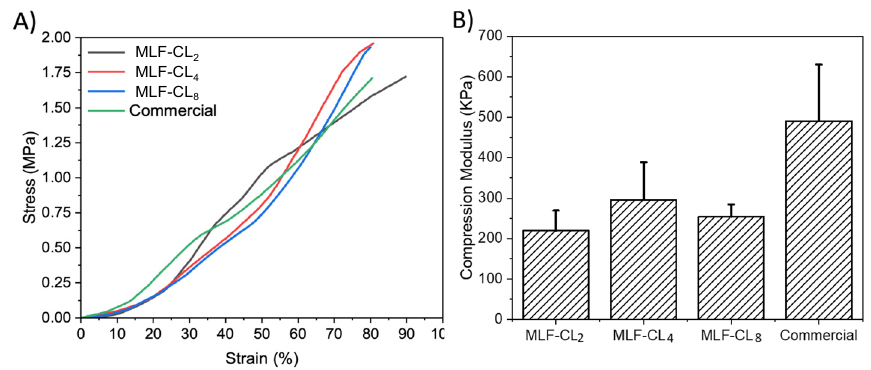
Figure 5. ( A ) Average stress–strain curves and ( B ) Compression modulus for miltefosine-eluting contact lenses (MLF-CLs) compared to commercial contact lenses. Quantitative data are expressed as mean ± standard deviation (SD). No significant statistical difference among samples. by Kruskal– Wallis Test. p = 0.1, n = 3.